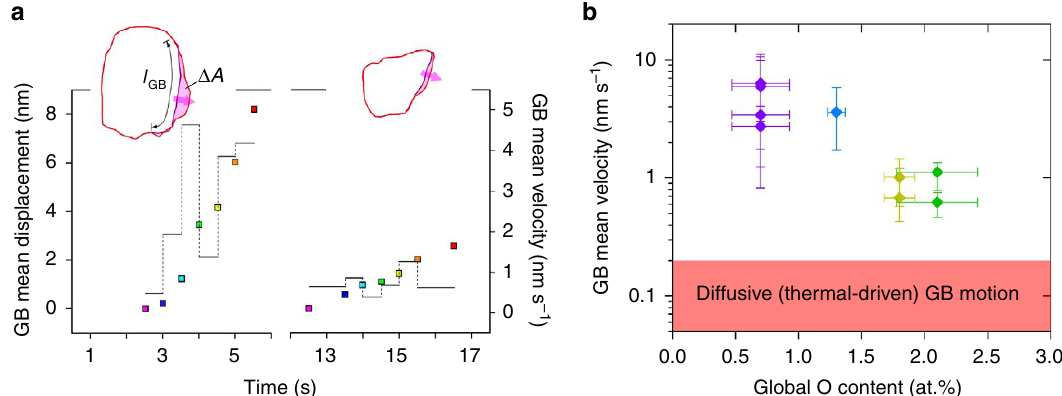
Figure 4 | Retardation of GB kinetics by impurities. ( a ) Direct measurements of GB displacements (colour squares, left axis) and velocities (black lines, right axis) over time during in situ TEM indentation tests of the films with C O ¼ 0.7at.% (left panel) and 2.1at.% (right panel). The effective displacements at each snapshot relative to the pre-deformed state are approximated by the area swept by the moving GB ( D A ) normalized by the original GB length ( l GB ), and the mean velocities between consecutive snapshots reveal GB migration in a jerky manner. ( b ) Dependence of GB mean velocities (averaged over each indentation test) on C O showing a significant retardation of GB migration owing to impurity pinning. Error bars of GB mean velocities for each test are determined as the s.d. of GB velocities shown in a . GB velocities representative of thermal-driven GB migration that is of a diffusive nature are shown in shaded region 24 , and are substantially lower than our measurements of stress-driven GB migration (over two orders of magnitude in the pure